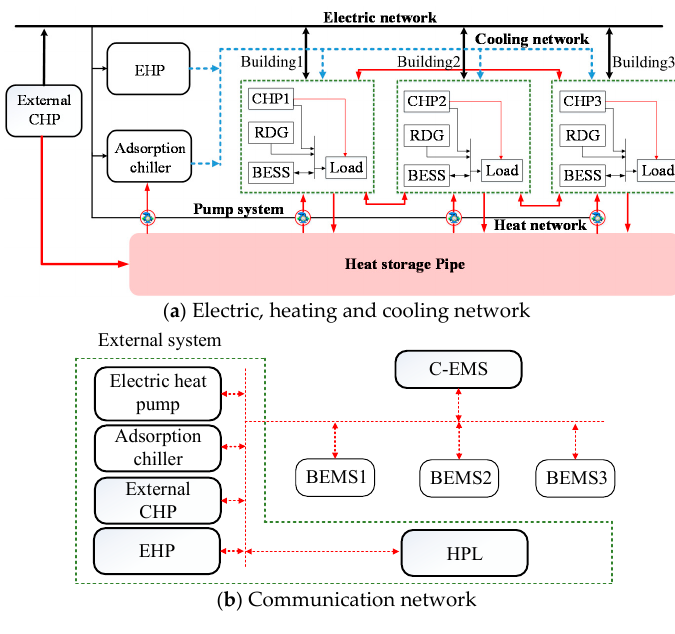
Figure 1. CCHP system configuration.